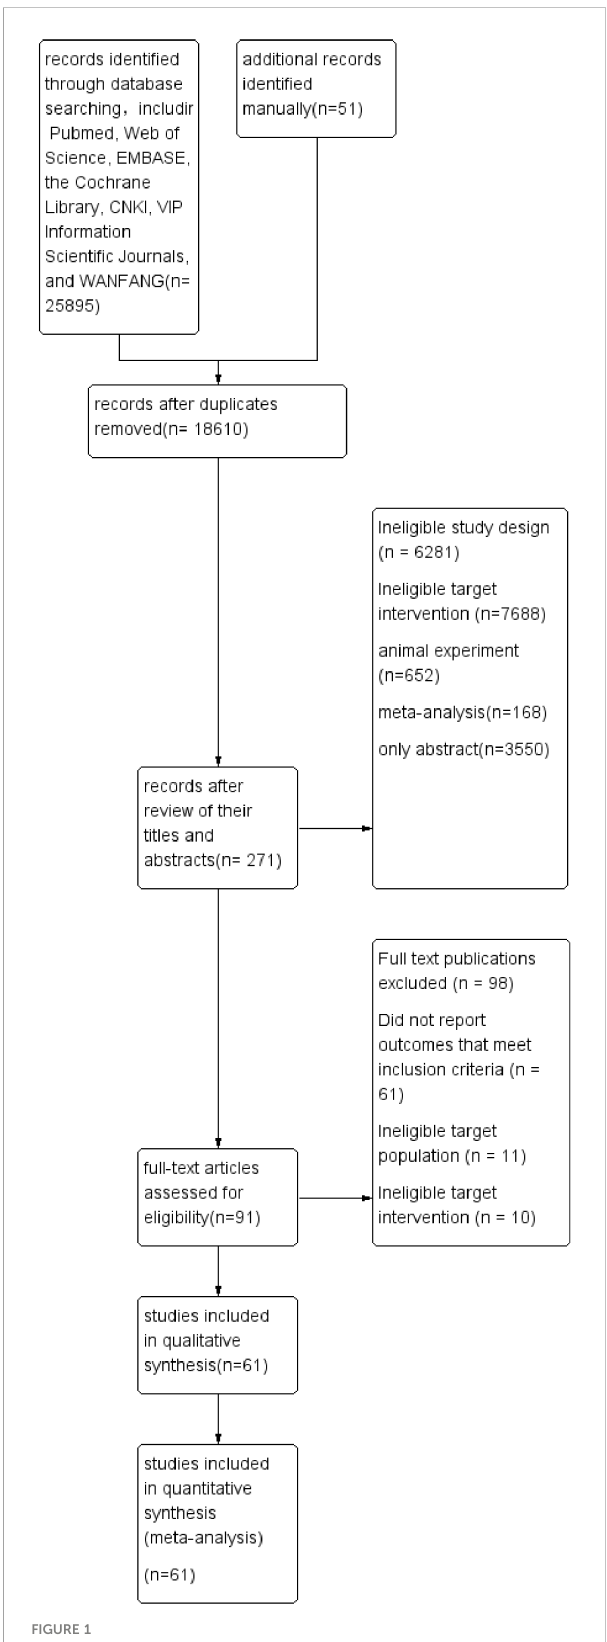
FIGURE 1 Flow diagram of study identi fi cation, inclusion, and